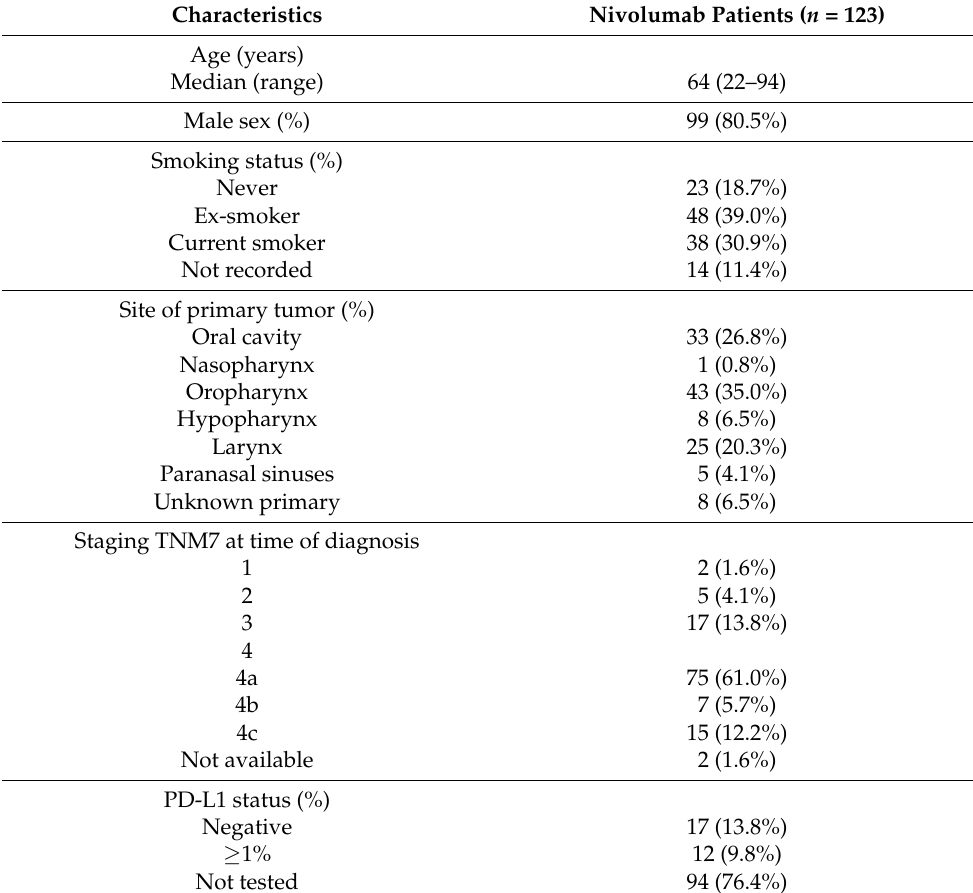
Table 1. Baseline tumor and patient